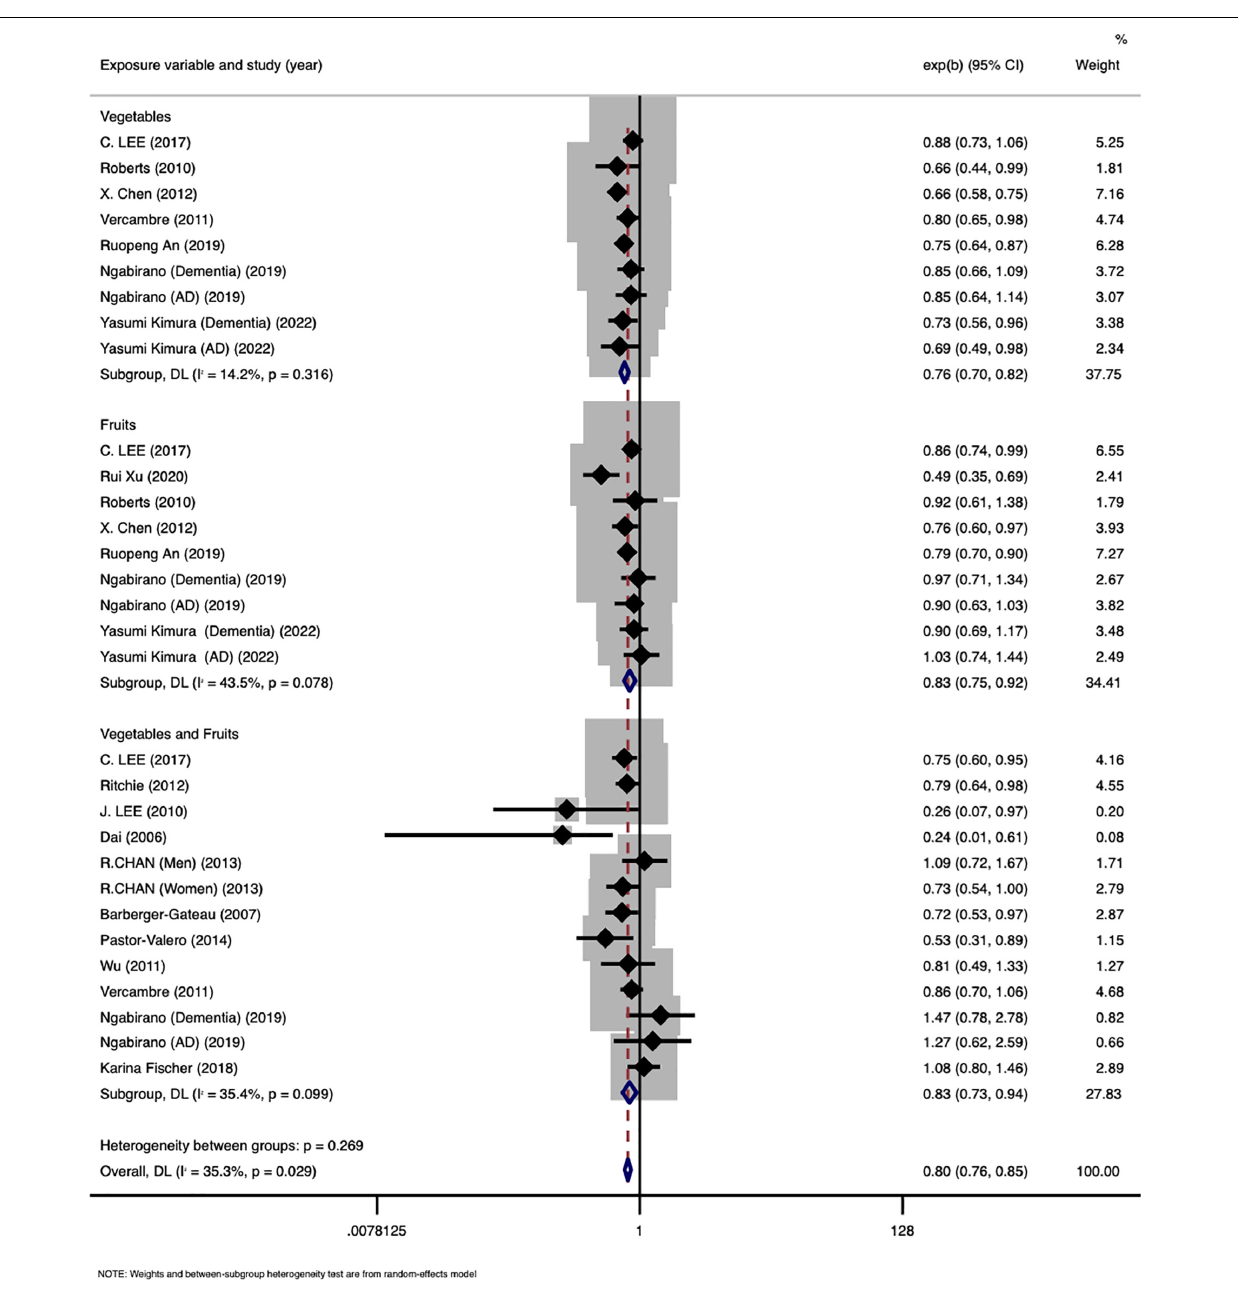
FIGURE 2 | Meta-analysis of the association between fruits and vegetables consumption and the prevalence of cognitive